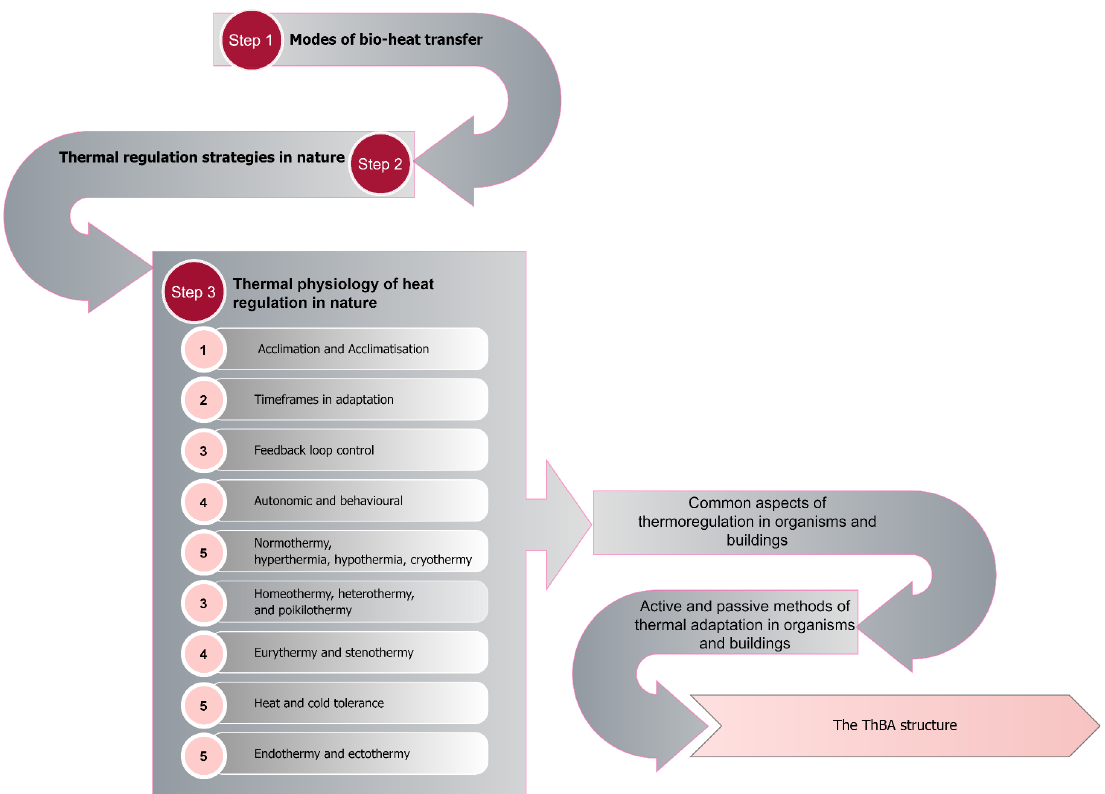
Figure 1. Steps in the literature review and their contribution to creating the ThBA.